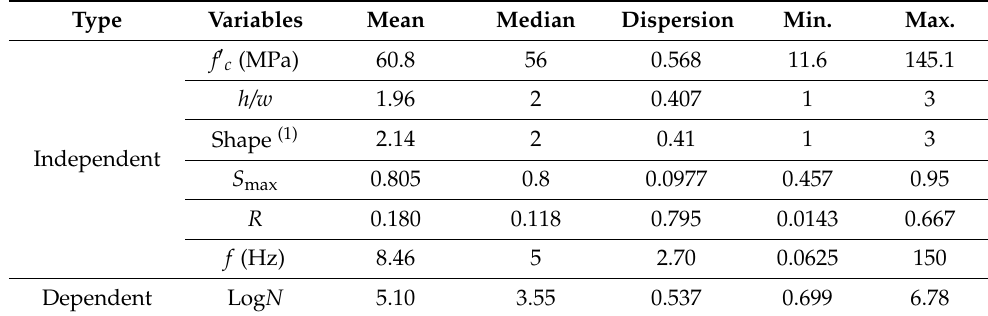
Table 1. Statistical features of original